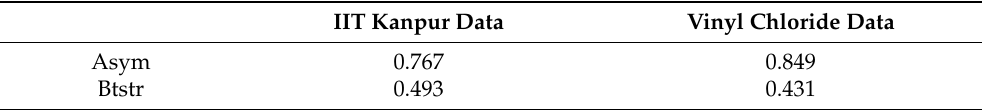
Table 6. Results of p -values for the test statistic in the special case of γ 0 = 2.5 for the two data sets. IIT Kanpur